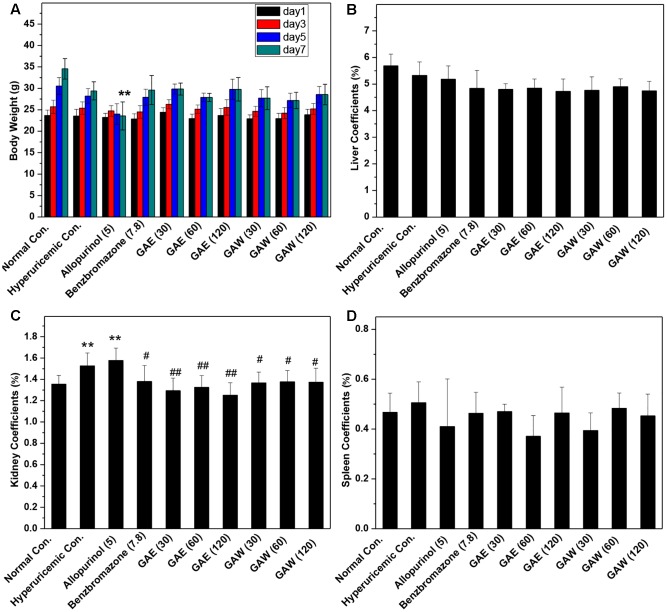
Effects of G. applanatum extracts on (A) body weight, (B) liver coefficients, (C) kidney coefficients, and (D) spleen coefficients in mice. ∗∗P < 0.01 as compared to the normal control; #P < 0.05, ##P < 0.01 as compared to the hyperuricemia control.